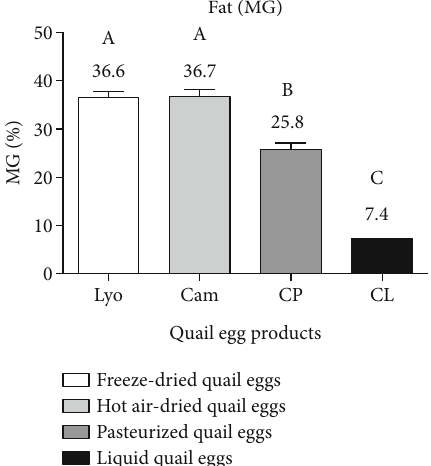
Figure 3: pH of liquid (CL), freeze-dried (Lyo), hot air-dried (Cam), and pasteurized (CP) quail eggs.